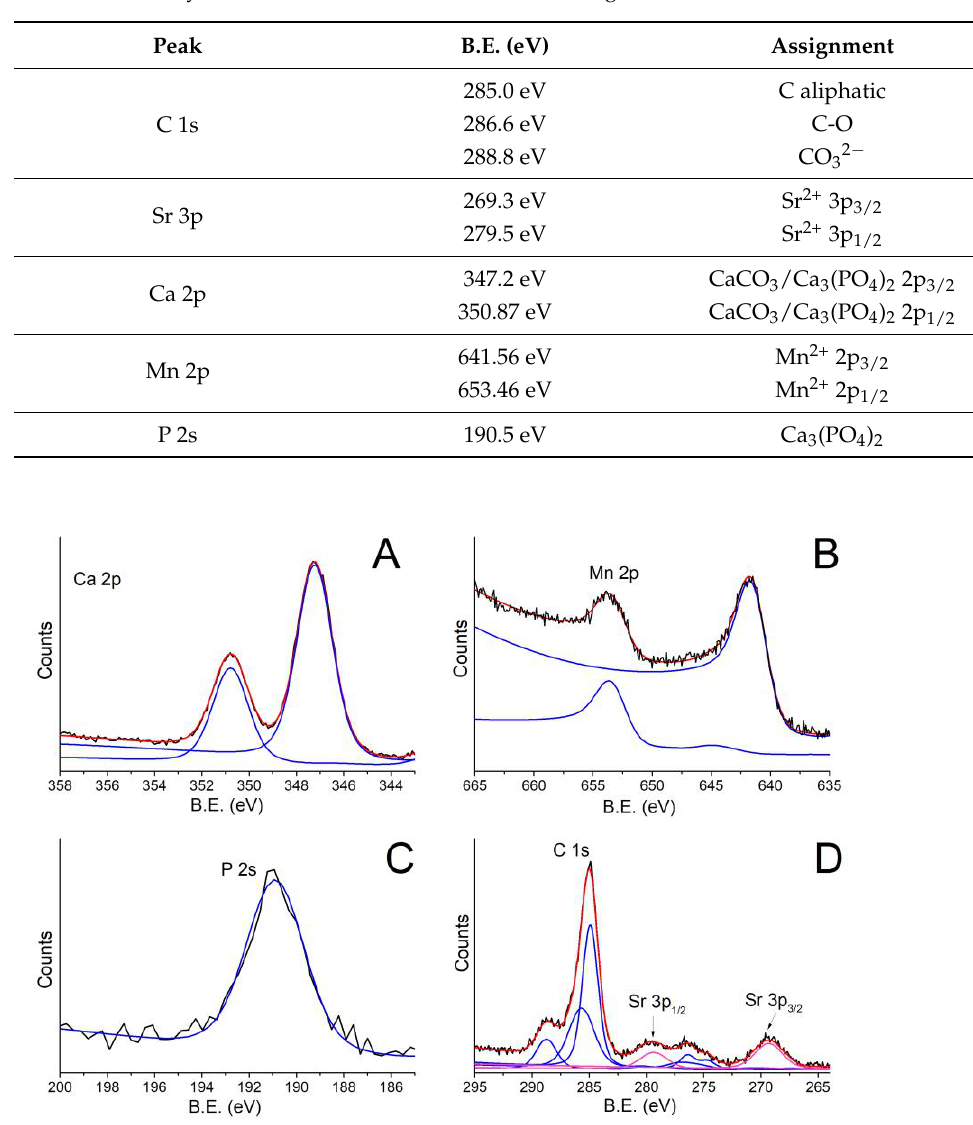
Figure 3. FTIR spectra of (a) Mn,Sr-TCP target and (b) Mn,Sr-TCP coating deposited on Si.